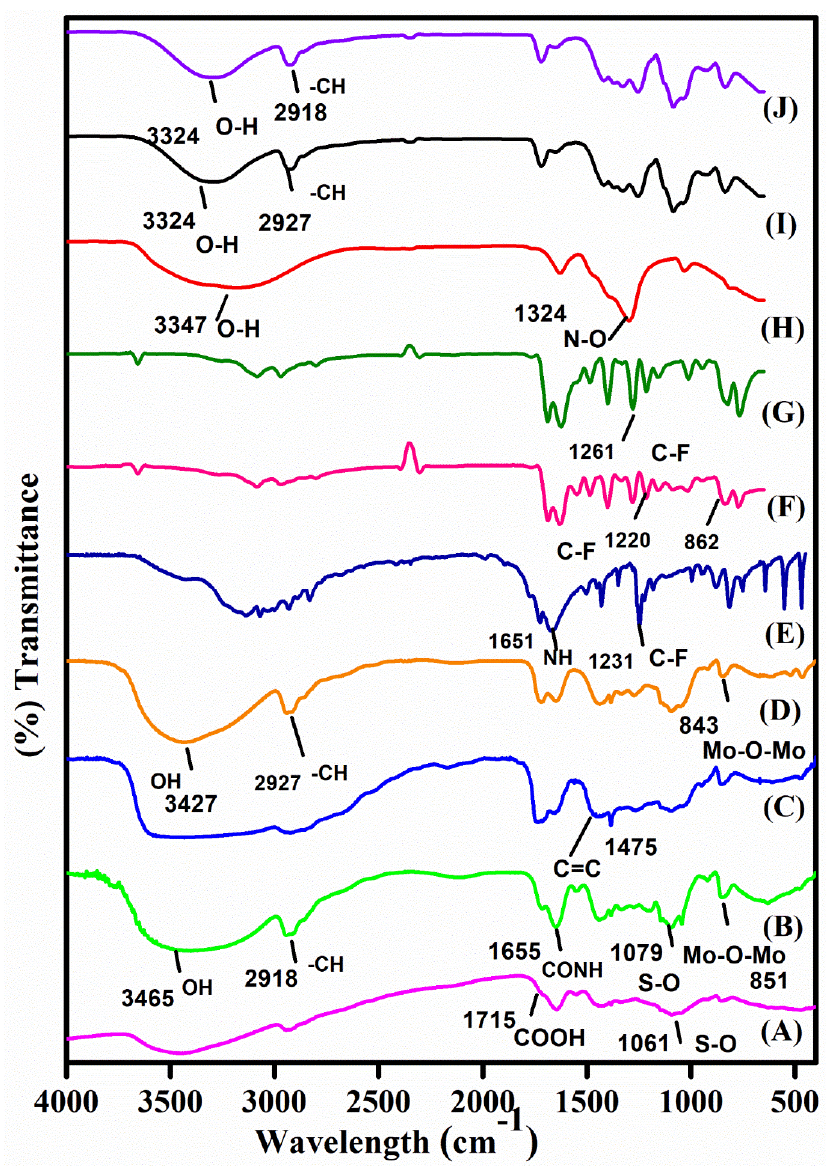
Figure 1. FTIR spectra of PSAAM ( A ), PSAAM-PMA ( B ), PSASB ( C ), PSASB-PMA ( D ) and 5FU ( E ); ATR-FTIR spectra of PSAAM-5FU ( F ), PSASB-5FU ( G ), Cu(NO 3 ) 2 .3H 2 O ( H ) PSAAM-Cu(II) ( I ) and PSASB-Cu(II) ( J